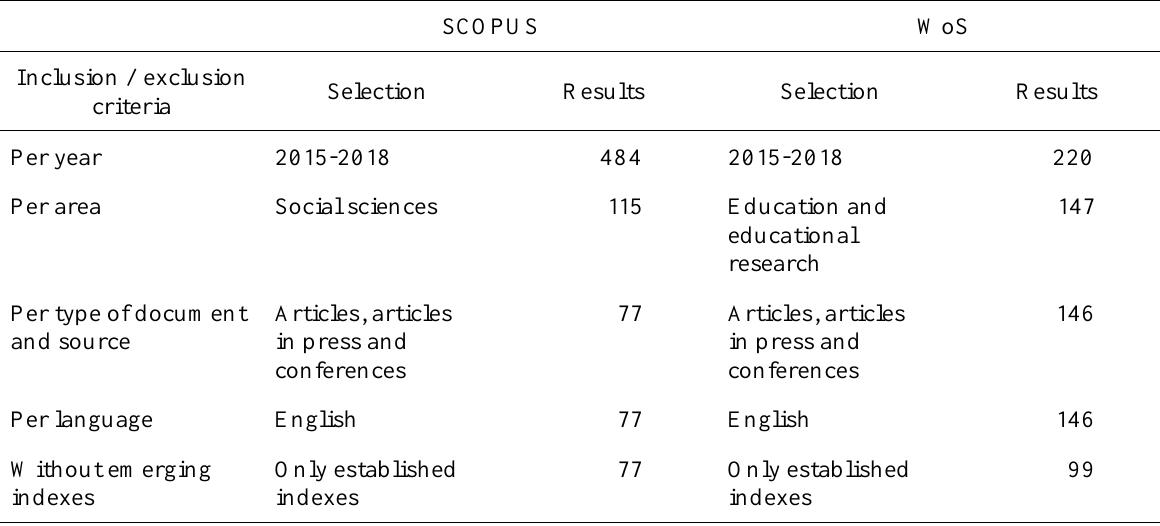
Table 2 Inclusion and Exclusion Criteria Results in Scopus and